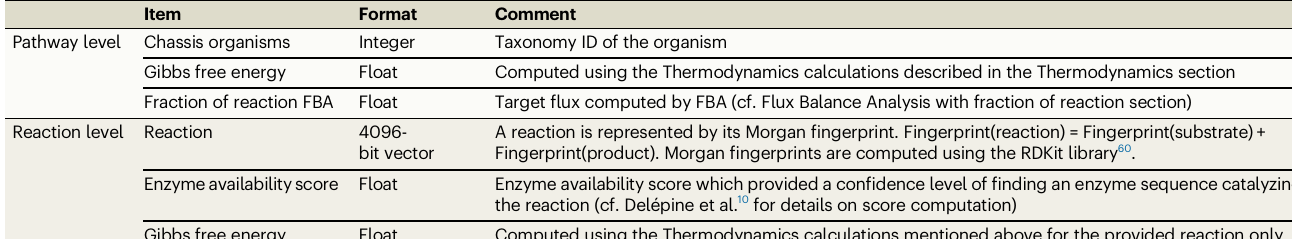
Table 3 | Pathway and reaction features used by the XGBoost classi fi er Item Format Comment Pathway level Chassis organisms Integer Taxonomy ID of the organism Gibbs free